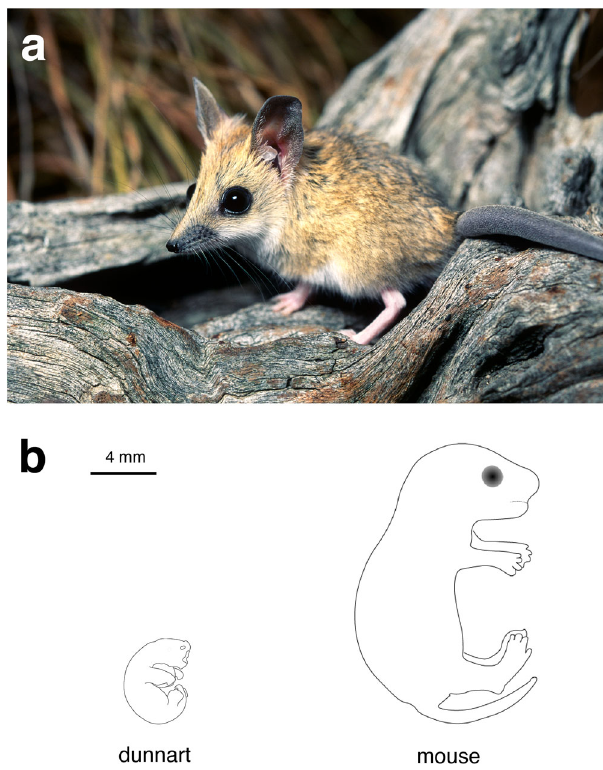
Fig. 1 At birth the fat-tailed dunnart represents one of the most altricial mammals in existence. a Adult fat-tailed dunnart ( S. crassicaudata ). Image: Alan Henderson — Minibeast Wildlife. b Schematic comparing extent of development of the fat-tailed dunnart and mouse ( M. musculus ) neonates on the day of